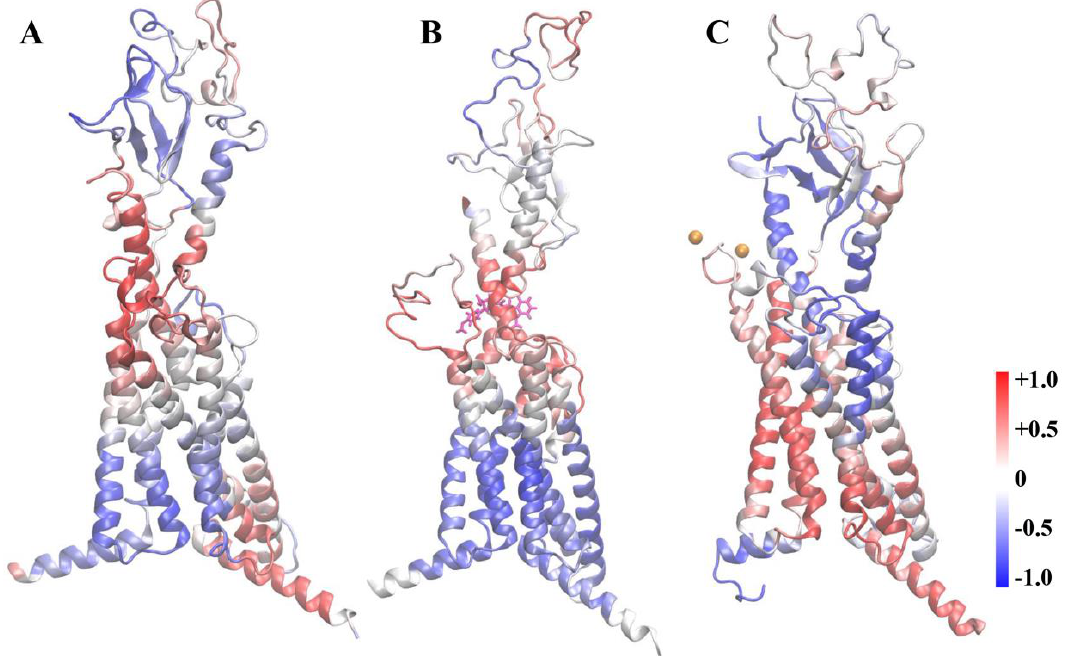
Figure 9. ANM results of the PTH1R – PTH – spep system ( A ), PTH1R – PTH – spep – NAM system ( B ), and PTH1R – PTH – spep – Ca 2+ system ( C ). The ribbon representation of the complex is colored by the correlation strength of all residues with PTH E22 that coordinate with NAM (correlated, red; anticorrelated, blue). NAM molecule is shown as sticks colored in magenta, and Ca 2+ ions are shown as orange spheres.